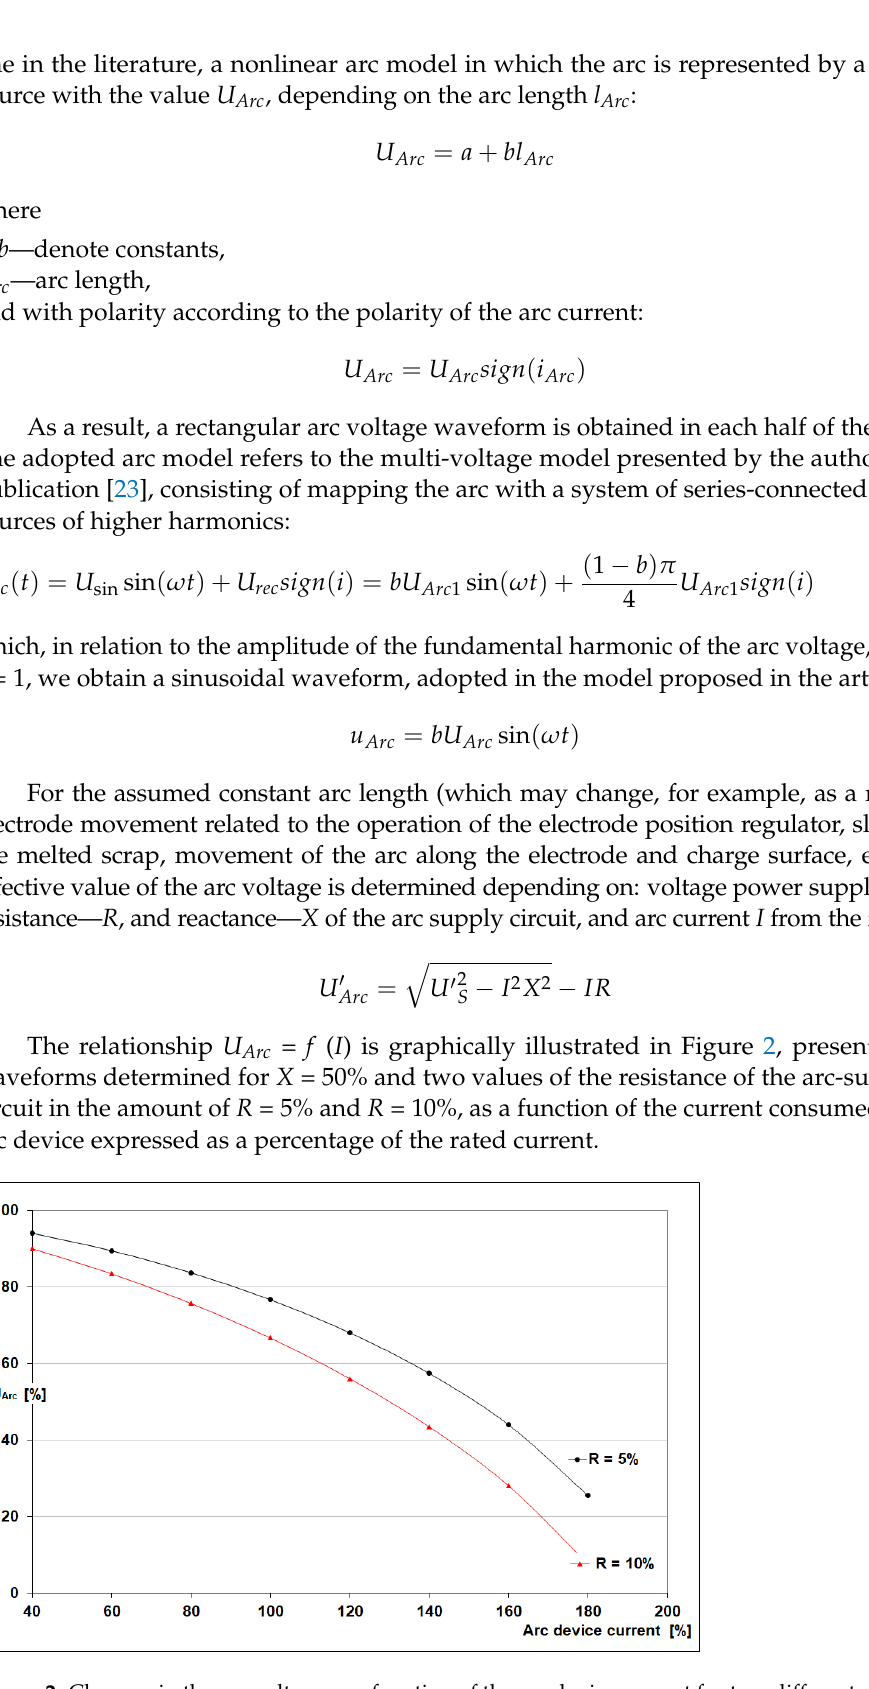
Figure 2. Changes in the arc voltage as a function of the arc device current for two different resistance values of the arc-supplying circuit.